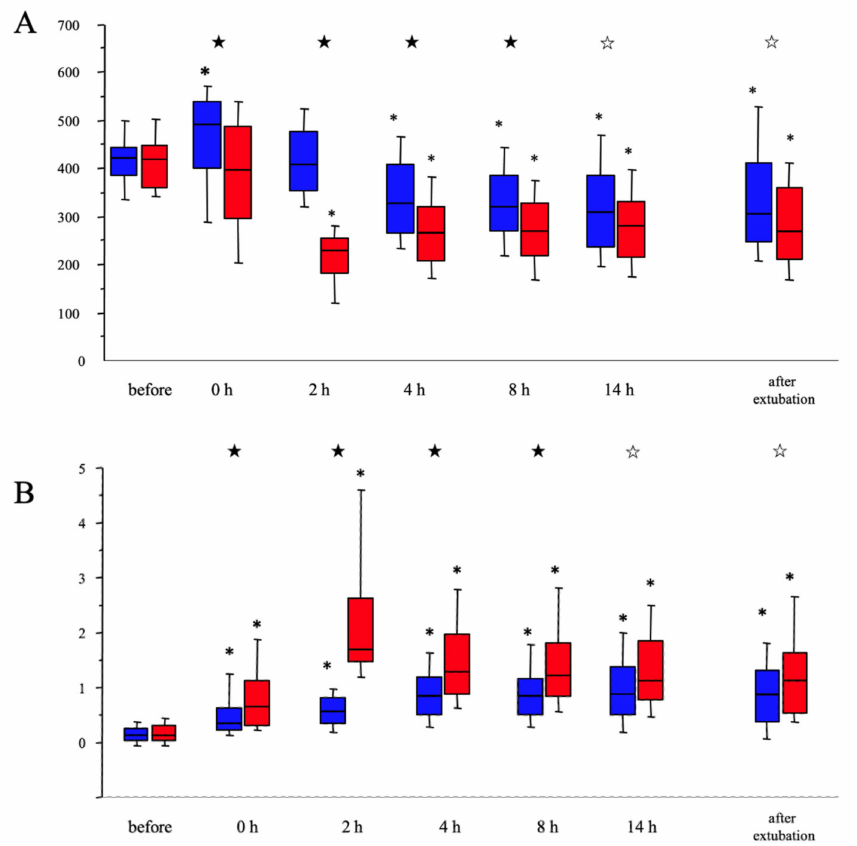
Figure 1. Time-dependent changes in PaO 2 /FiO 2 (PFR) and respiratory index (RI) in patients with and without post-cardiopulmonary bypass (CPB) lung injury (PCLI). ( A ) Time-dependent changes in PFR. PFR was significantly decreased after CPB in patients with PCLI. PFR was higher in patients without PCLI as compared to patients with PCLI throughout the observation period, except before surgery. PFRs at 4, 8, and 12 h after surgery and after extubation were significantly decreased compared with PFRs in the preoperative period. ( B ) Time-dependent changes in RI. RI was significantly increased after CPB in both groups. RI was always higher in patients with PCLI compared to RI in patients without PCLI. * 1 , p < 0.05 vs. before surgery; * 2 , p < 0.05 vs. before surgery; (cid:70) p < 0.001 between patients with and without PCLI; (cid:73) , p < 0.01 between patients with and without